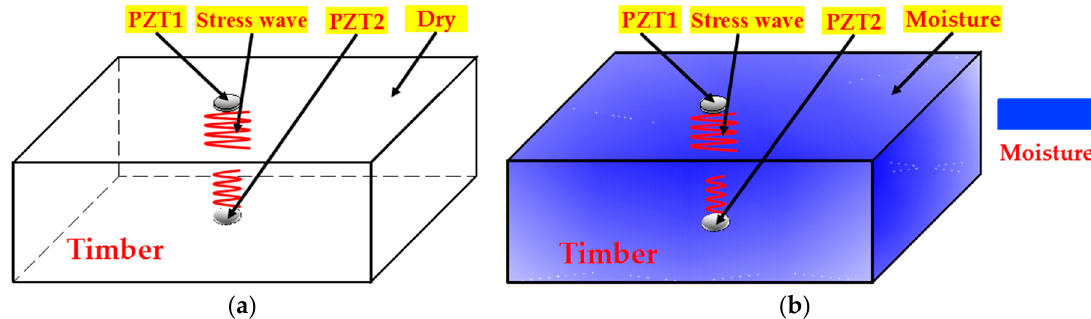
Figure 1. Stress-wave-based active sensing approach to monitor timber moisture content. ( a ) Dry timber (relatively stronger wave detected by PZT2); ( b ) timber with higher moisture-content level (relatively weaker wave detected by PZT1).